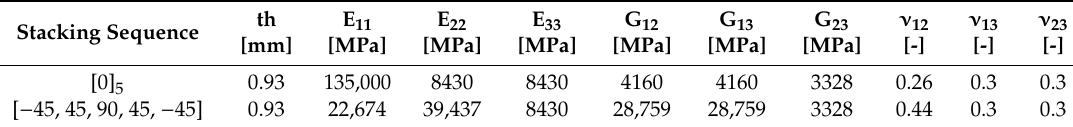
Table 7. Equivalent sublaminate mechanical properties.